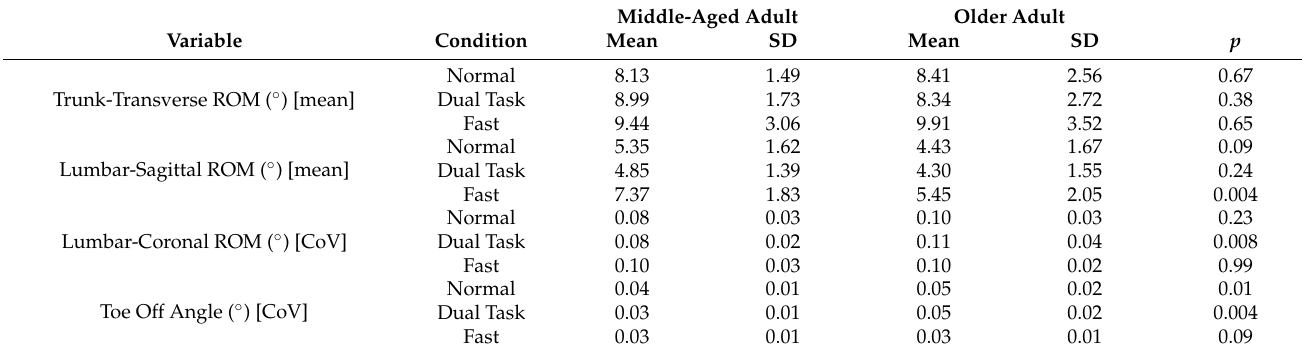
Table A2. Group by Condition post-hoc for gait variables demonstrating a significant interaction between Middle-aged Adults and Older Adults. ROM—range of motion, CoV—Coefficient of Variation, p —post-hoc significance.